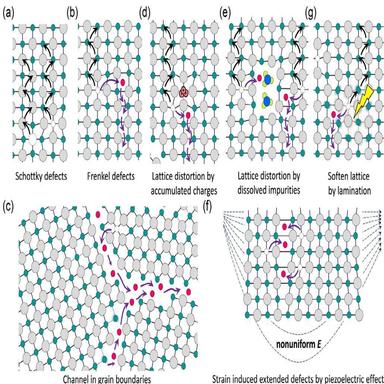
Illustration of the ion migration pathways caused by different possibilities. Copyright 2016, American Chemical Society.